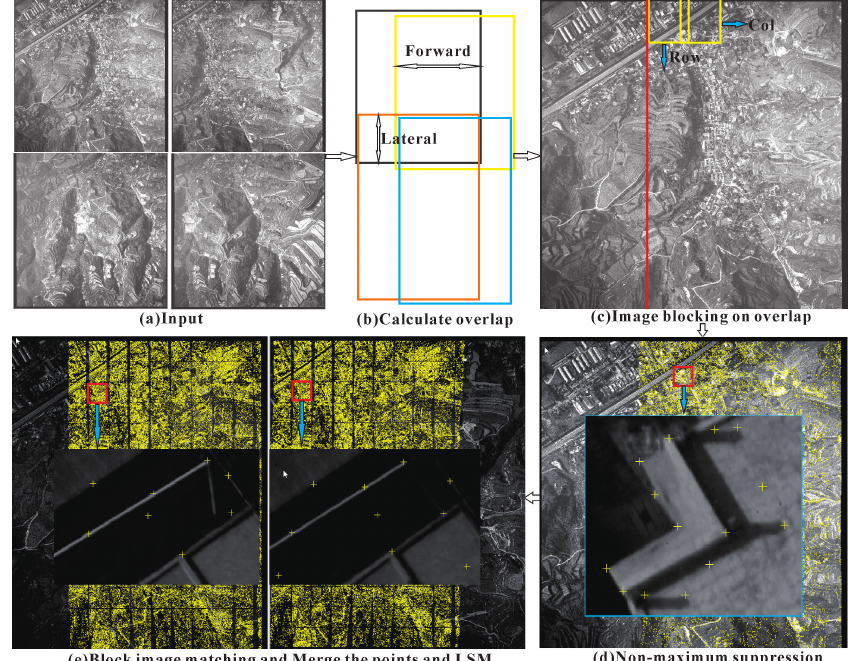
Figure 3. Workflow of proposed LR-SuperGlue. ( a ) is the input images; ( b ) calculates the overlap of two images in forward and lateral direction; ( c ) image block matching with SuperGlue(the yellow box represents the image block); ( d ) is the NMS; ( e ) merges block points and RANSAC, LSM (the yellow “+” represents the matching